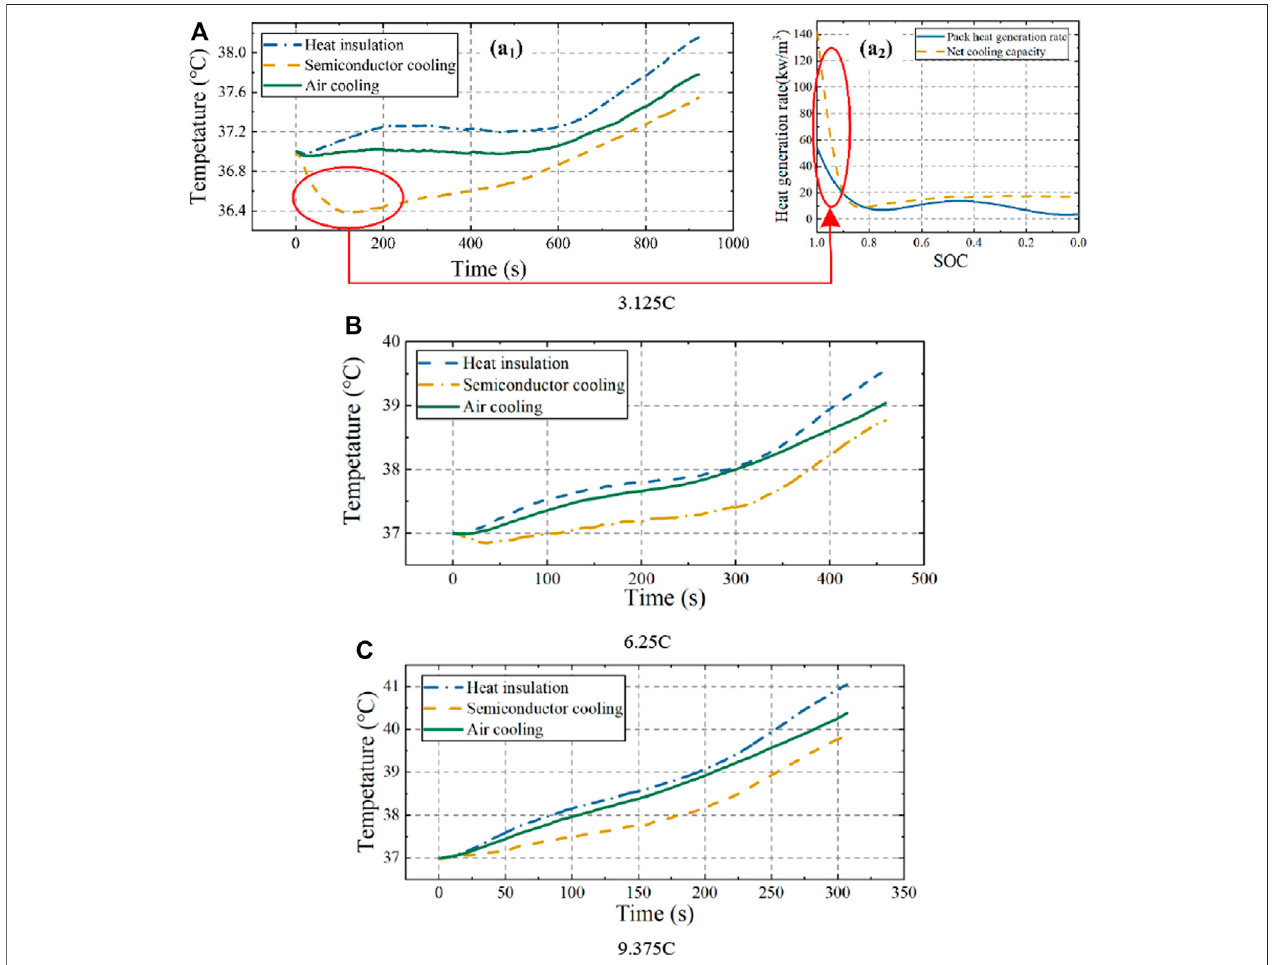
FIGURE 10 | Battery pack temperature performance under adiabatic, semiconductor with 2A current cooling and air-cooled conditions at 37 ° C.